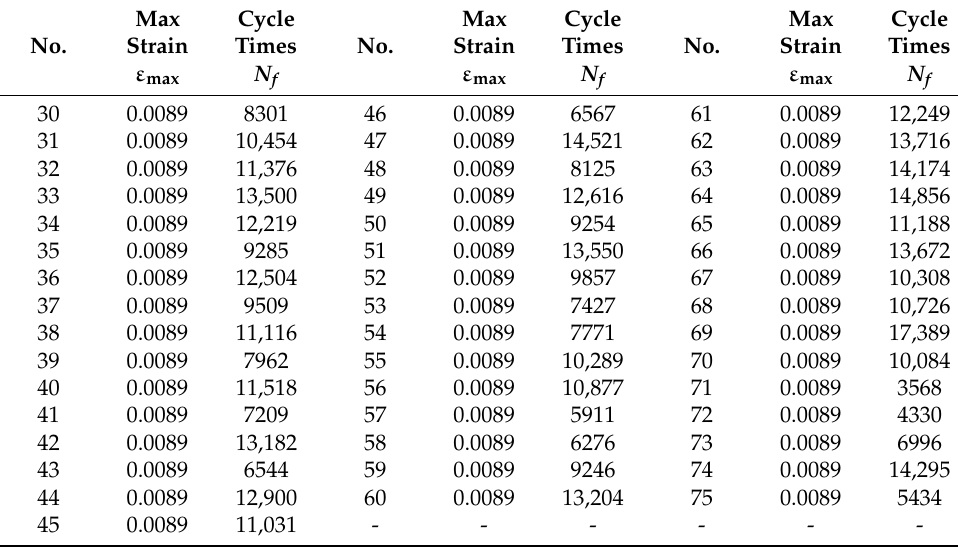
Table A2. Fatigue test data of T = 530 ◦ C, R = 0.05, strain range